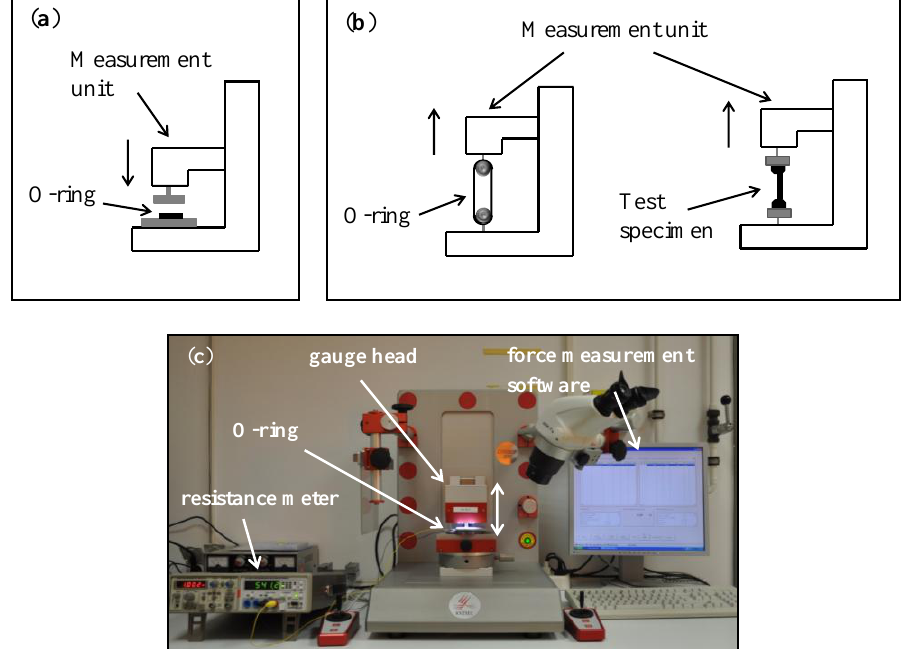
Figure 6. Sketches of the measurement setup. ( a ) for pressure tests; ( b ) pull-tests; ( c ) photograph of the measurement setup for pressure